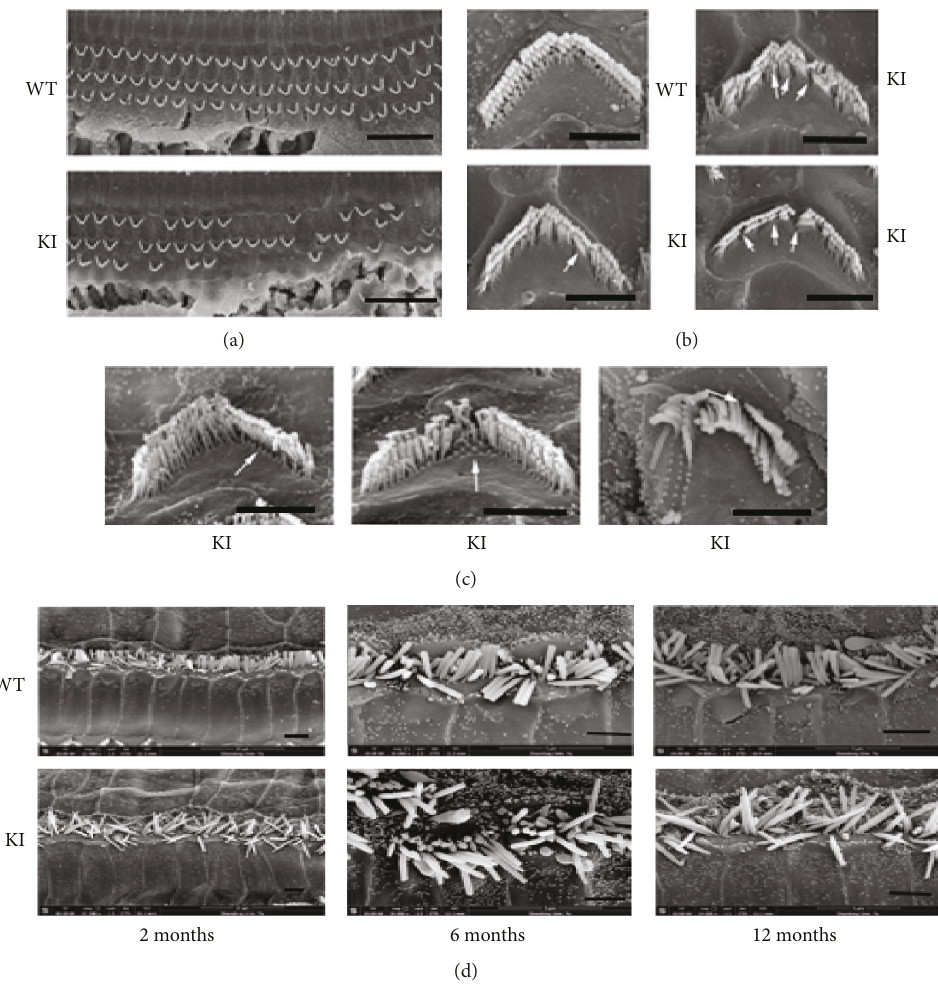
Figure 5: SEM images showed the abnormal structure of the stereocilia in Myo3a mutant mice. (a) The outer hair cell stereocilium loss was serious in 6-month-old Myo3a mutant mice. (b) Fusion phenomenon was observed in some stereocilia of mutant mice. (c) The stereocilia of some outer hair cells were found to be shorter, and the degeneration started from the innermost line of the stereocilia. (d) The stereocilia of inner hair cells become sharp in Myo3a mutant mice at the age of 2 months, 6 months, and 12 months. Scale bar =10 μ m for (a) and 2 μ m for (b, c, and